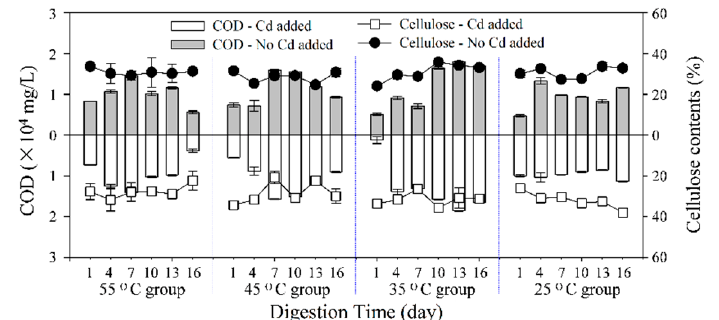
Figure 5. Chemical oxygen demand (COD) of the no Cd-added group and Cd-added group with digestion temperatures of 55 °C, 45 °C, 35 °C, and 25 °C.